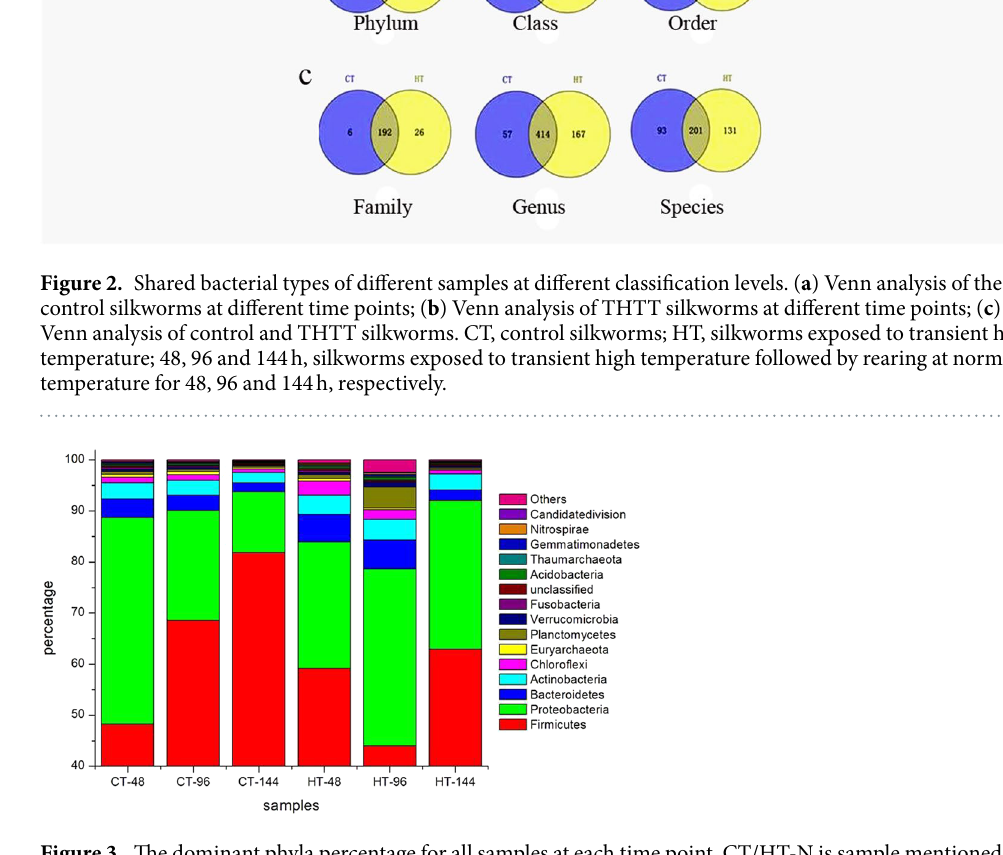
Figure 3. The dominant phyla percentage for all samples at each time point. CT/HT-N is sample mentioned in Table